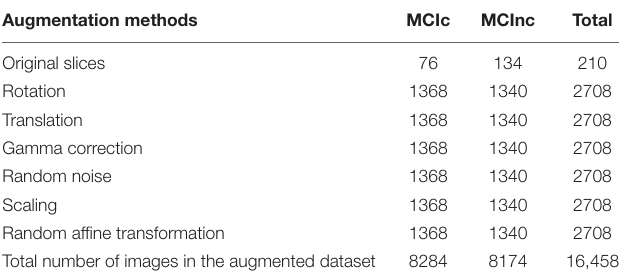
TABLE 2 | Numbers of augmented images in the MCIc and MCInc datasets.